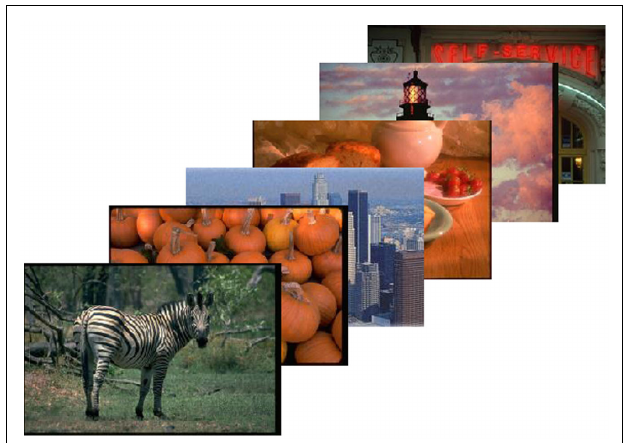
FIGURE 2 |An illustration of an RSVP sequence of pictures.